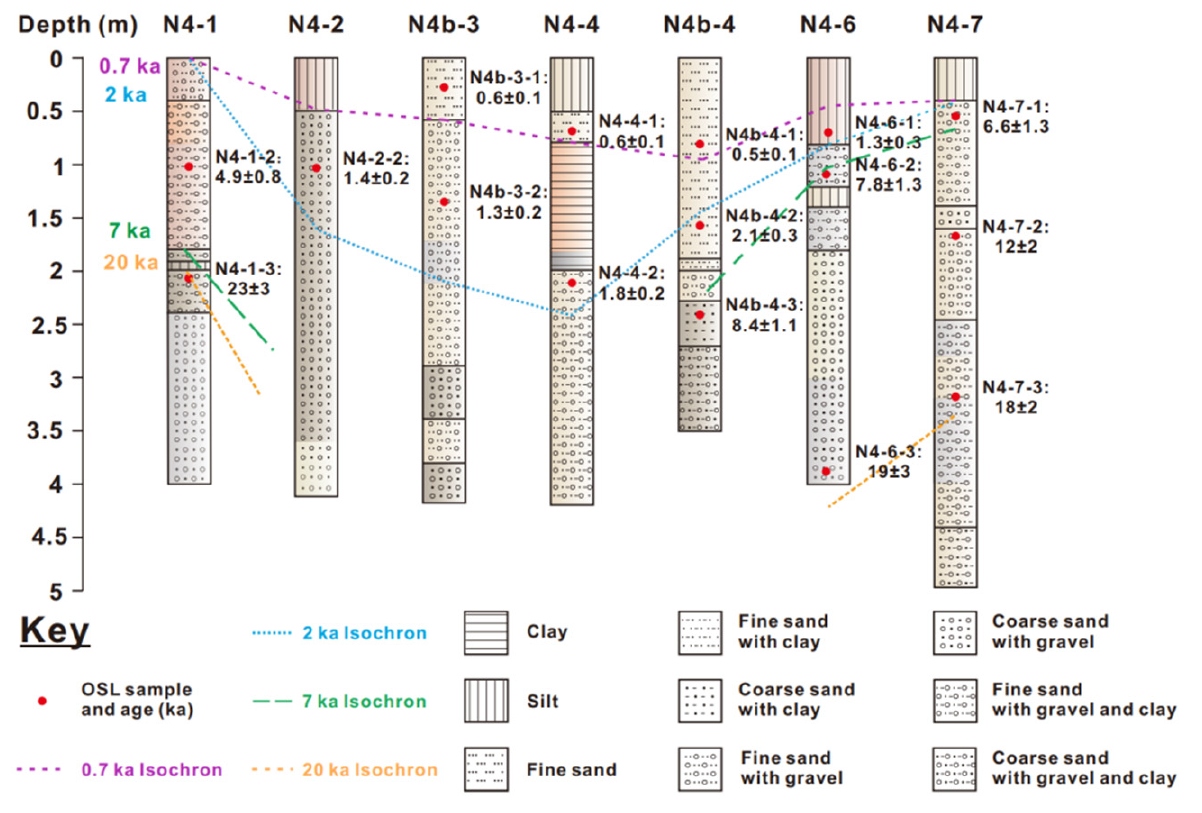
Figure 8. Drilled cores and dating results. Table 2. Characterization of riverbed sediments at N4 profile of the Nangqian section along the Zhaqu